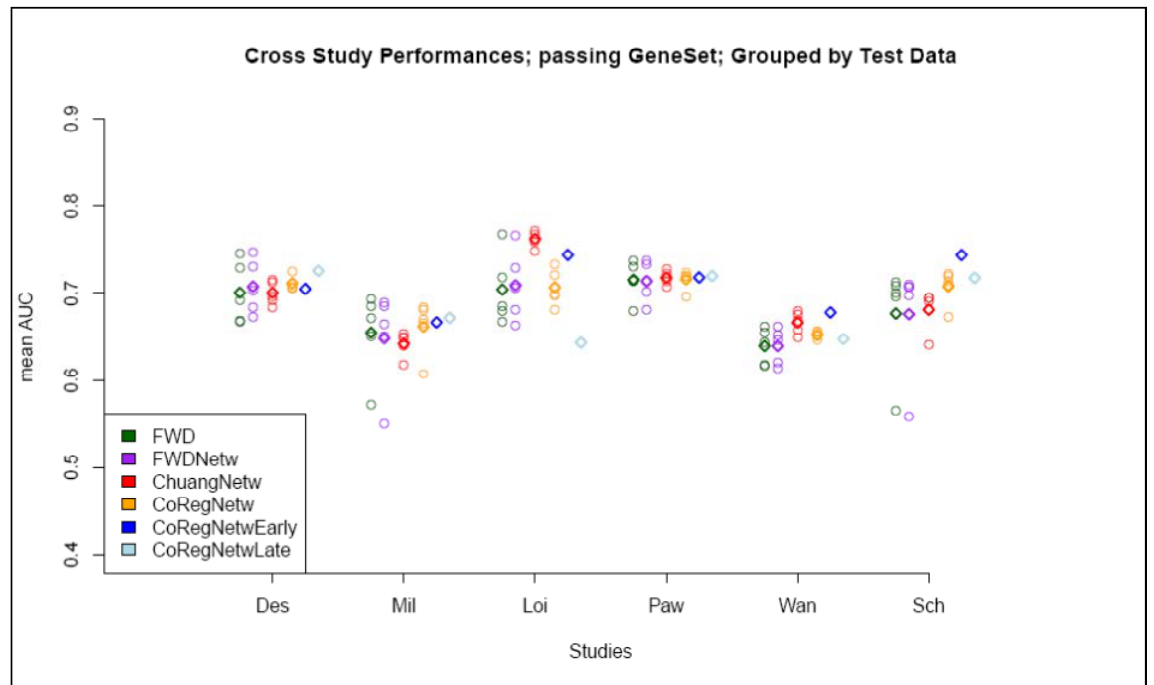
Figure 5: Cross study prediction performances of several methods grouped per evaluation study in the “ passing GeneSet ” setting. Circles indicate results of cross study prediction performances involving a single study for training, diamonds show results involving five studies for training. The latter can either be a summarization statistic (mean) or be the result of an integration approach (CoRegNetwEarly and